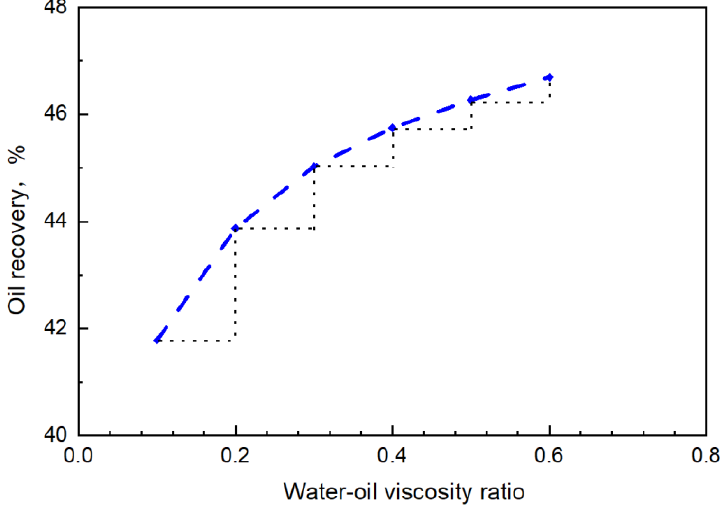
Figure 19. Oil recovery under different water – oil viscosity ratios.